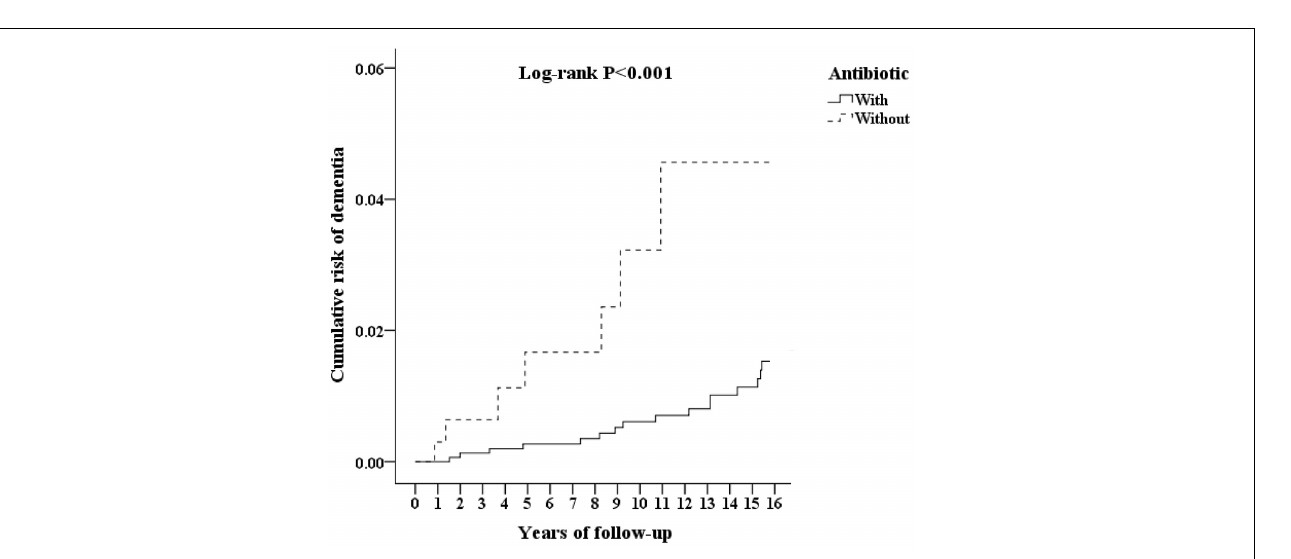
Frontiers in Aging Neuroscience |